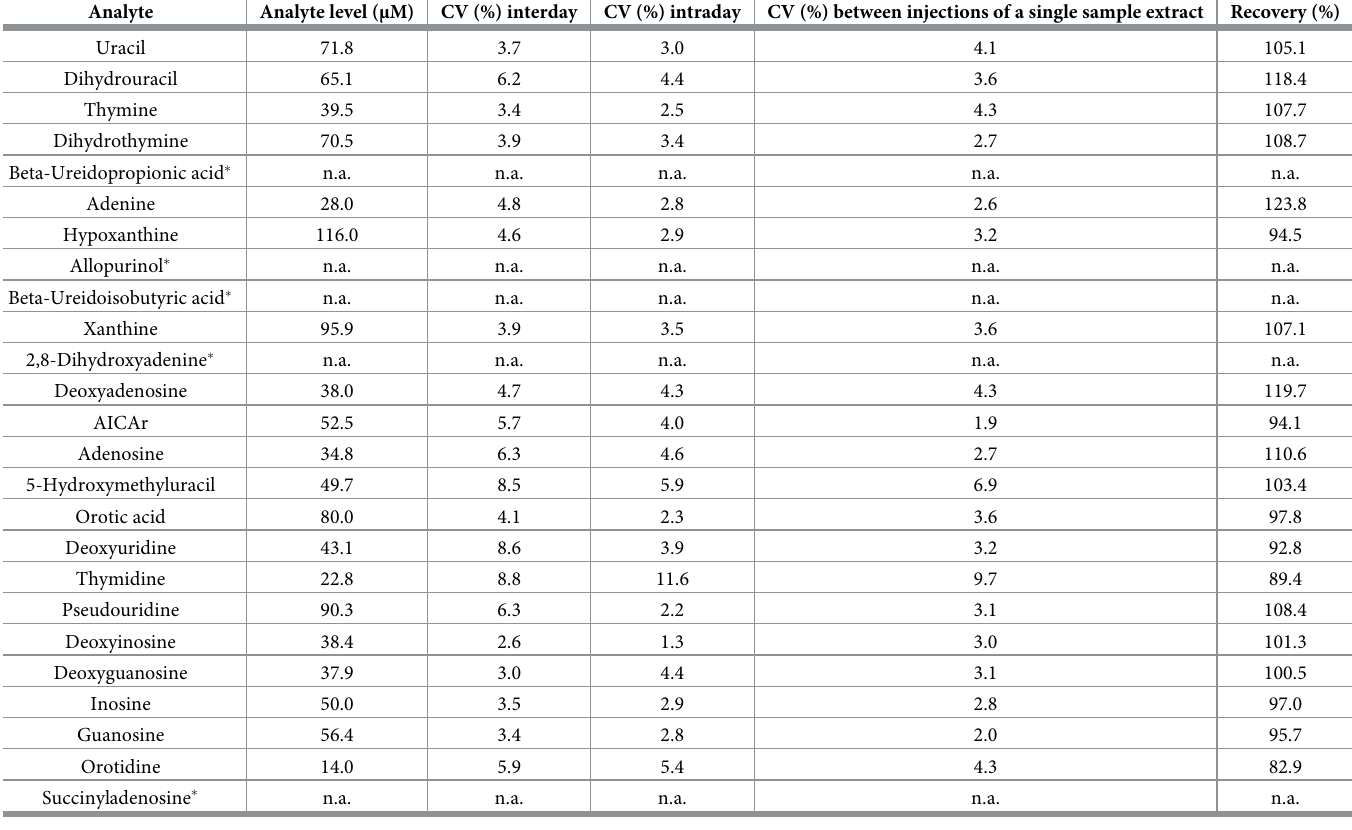
Table 3. Assay validation using the ERNDIM „Control Purines and Pyrimidines” external quality control samples (EQC; LOT used for method development: 2015.010) ( n =